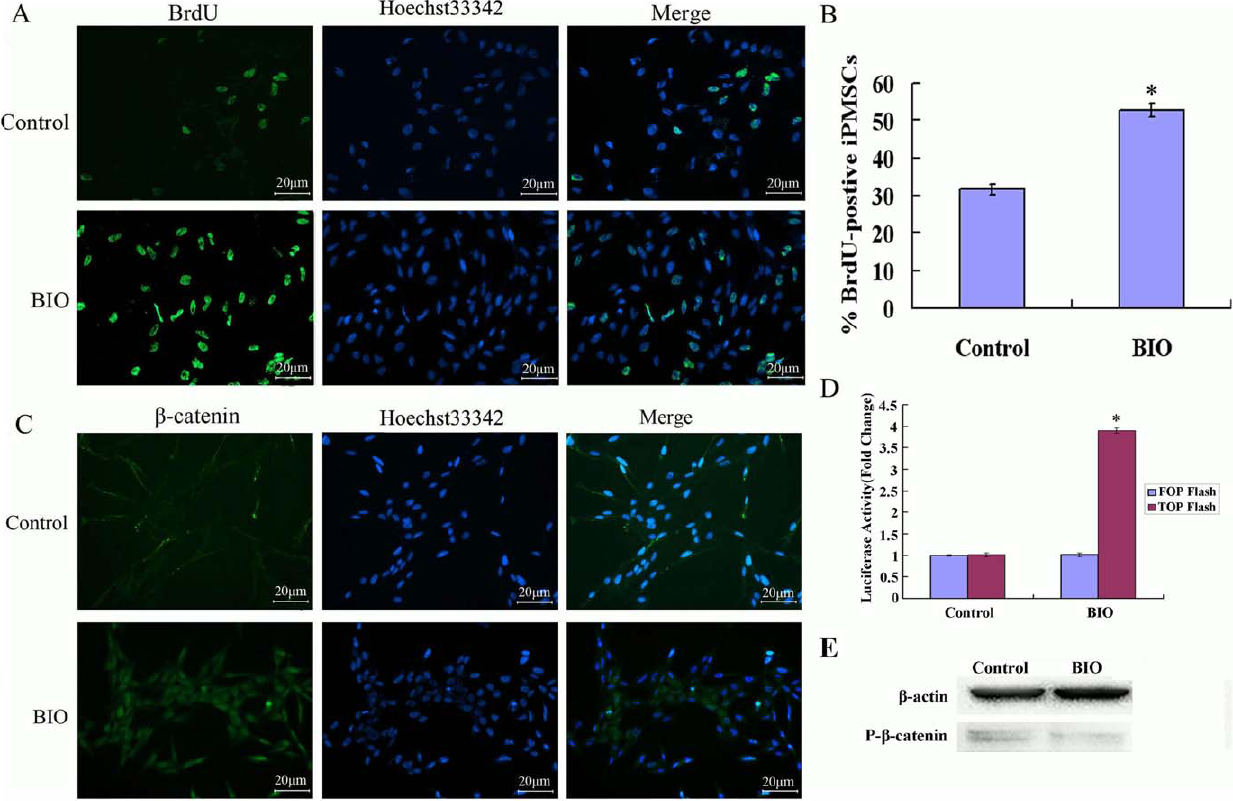
Figure 3. b -catenin and BrdU incorporation assay. A, The mitiosis index with BIO was significantly higher than without BIO medium; B, The percentage of positive cells treated with BIO or not from A; C, BIO treatment caused nuclear accumulation of b -catenin, which was not observed in control cells; D, Cells were assayed for b -catenin-mediated transcriptional activation by using a reporter containing either functional (TOP-Flash) or mutated (FOP-Flash) Tcf binding sites. Cells stimulated with BIO showed rise in the levels of b -catenin activity, as measured by luciferase activity. Treatment with BIO resulted in the higher fold change (almost 4 fold) when TOP-Flash activity was normalized against FOP-Flash activity. There was no significant difference in activities in the presence of the mutated FOP-Flash reporter; C, Bar=20 m m, *P , 0.05; E, Western blotting showed that p- b -catenin (S33/37/T41) was decreased in BIO treated.